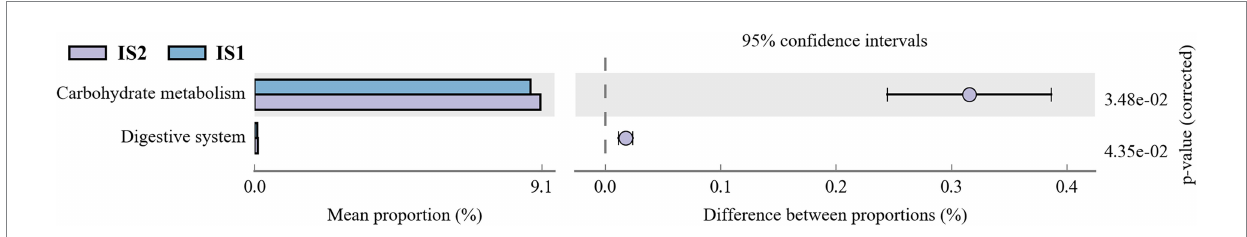
FIGURE 4 The differential KEGG pathways (at level 2) within treatments based on Tax4Fun function